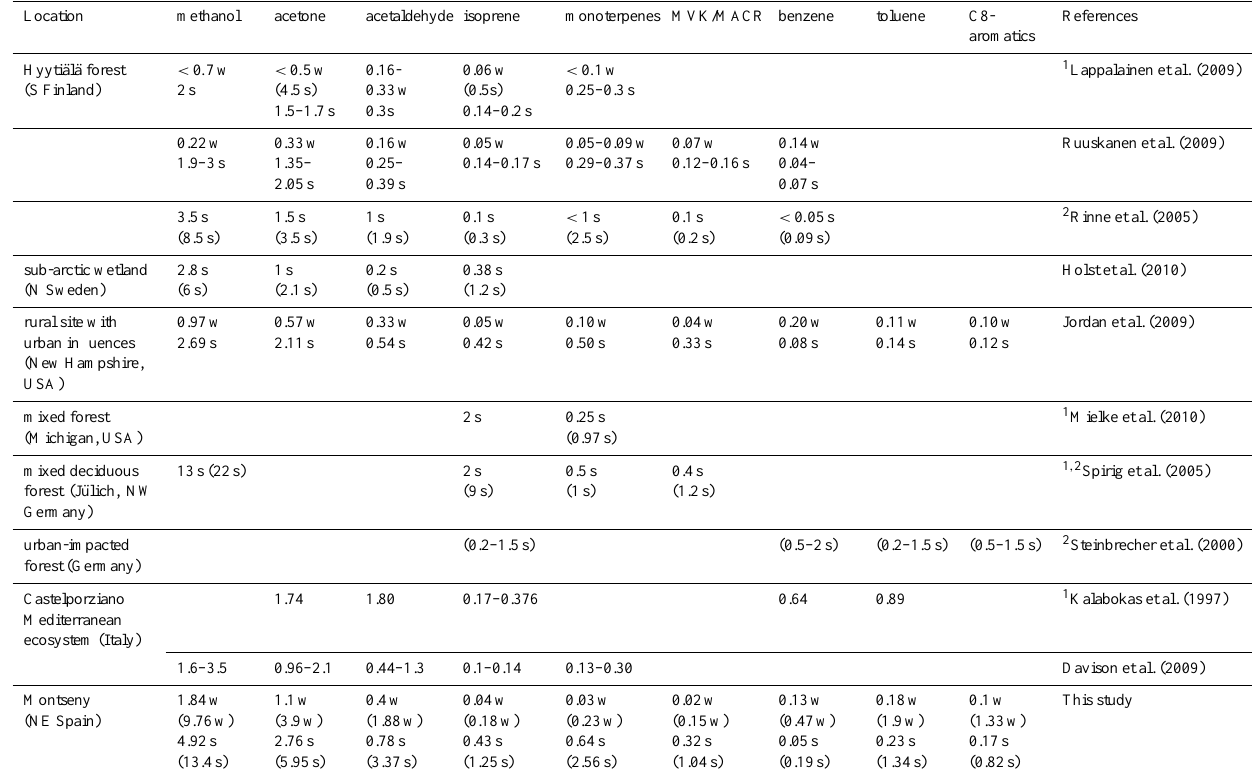
Table 3. VOC mixing ratios (ppbv) reported in the literature for several natural environments (either Scandinavian ecosystems, other mixed forests and rural sites, or Mediterranean ecosystems). Numbers represent means or medians, while numbers in brackets represent maximum values reported by the authors. The numbers are followed by a letter to indicate the time of year when they were recorded (w for winter, s for summer). The Castelporziano Mediterranean values were obtained in